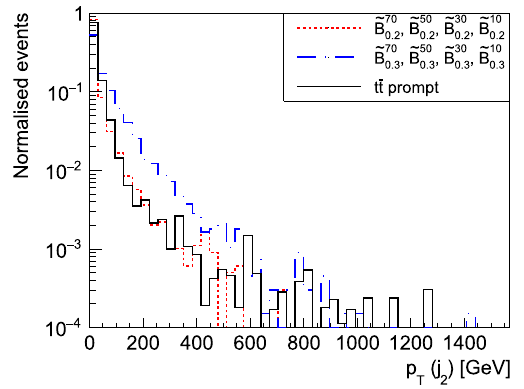
Fig. 25 Jet multiplicity N j in the ˜ h 2 -like case